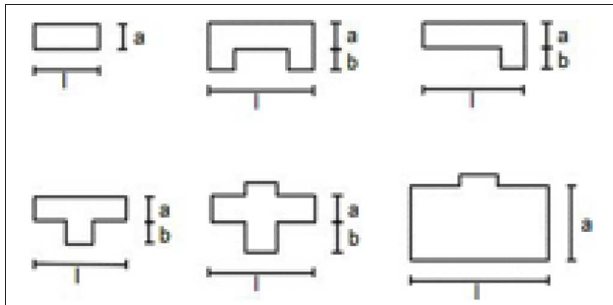
FIGURE 1 | In-plane configuration